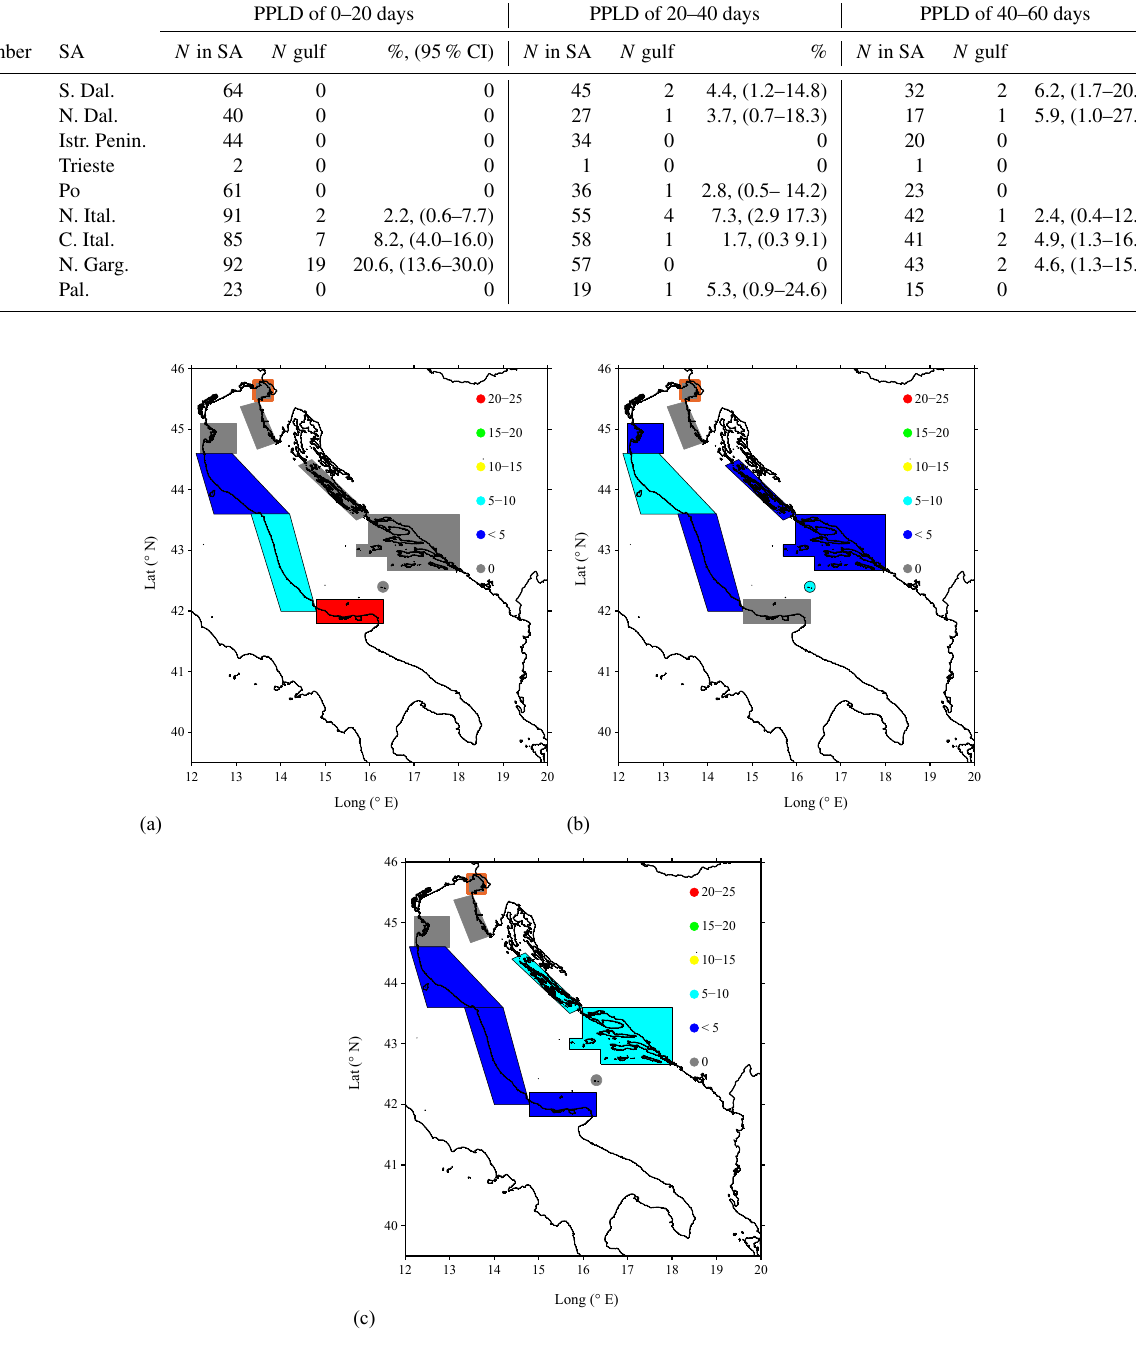
Figure 7. The connection percentages (i.e., percentage of drifters that passed through a given SA and reached the Gulf of Manfredonia) for sardine spawning season (see Table ) over the following PPLD ranges: (a) 0–20 days; (b) 20–40 days; (c) 40–60 days. Results obtained with less than 10 drifters per SA, as for the Gulf of Trieste (SA 4; see Table ), are disregarded and identified by the orange contour around the